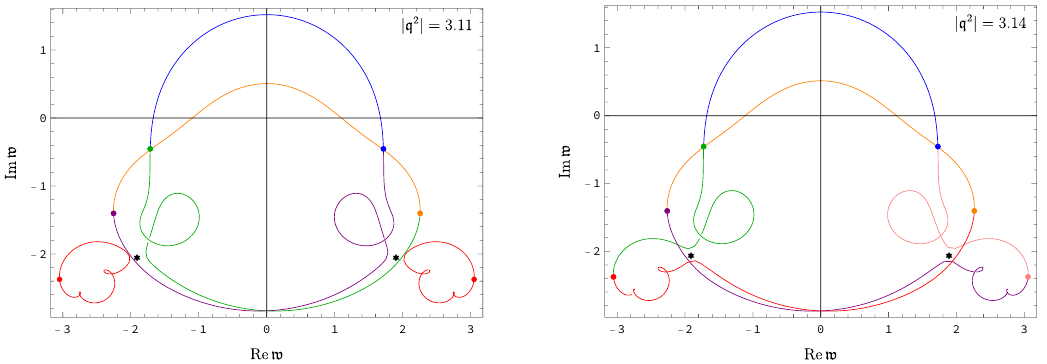
Figure 11 . Quasinormal spectrum (poles of the retarded energy-momentum tensor two-point function in the N = 4 SYM theory) in the sound channel plotted in the complex w -plane for di(cid:11)erent values of the complex momentum q 2 = j q 2 j e i(cid:18) . Large dots in all four plots correspond to the location of the poles for purely real momentum, q 2 (i.e. at (cid:18) = 0) [41]. What is shown is the level-crossing phenomenon for the critical points in eq.